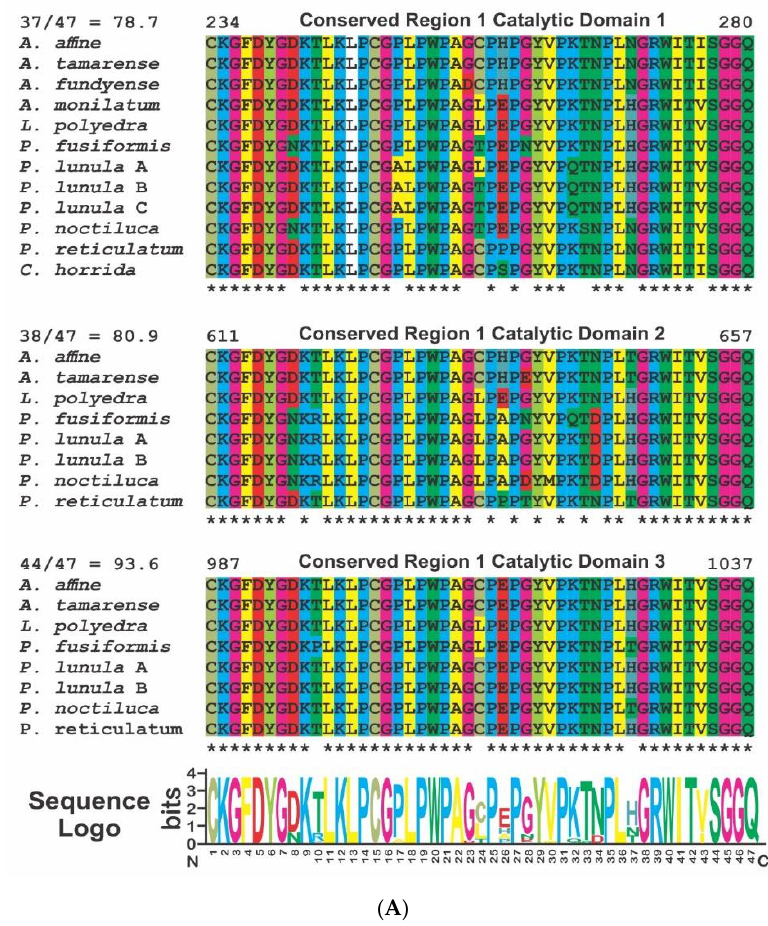
regions 1 (red) and 2 (green), made with Phyre2 web server and visualized with EzMol, as described in the